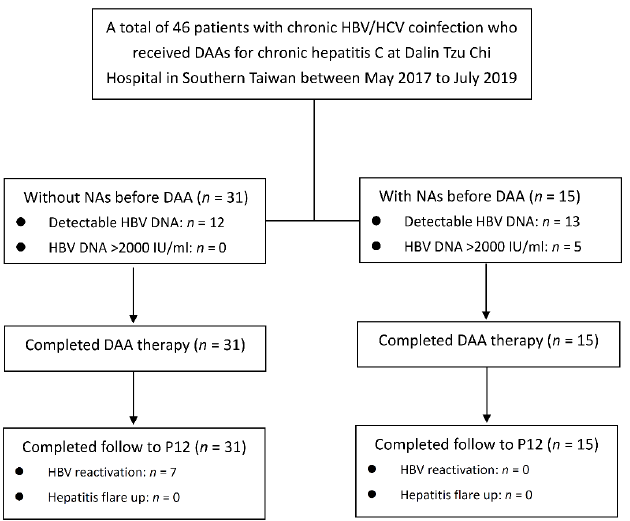
Figure 1. Patient allocation flow chart. DAA, direct-acting antiviral; NAs, nucleot(s)ide analogue; P12,12th week post-DAA treatment.